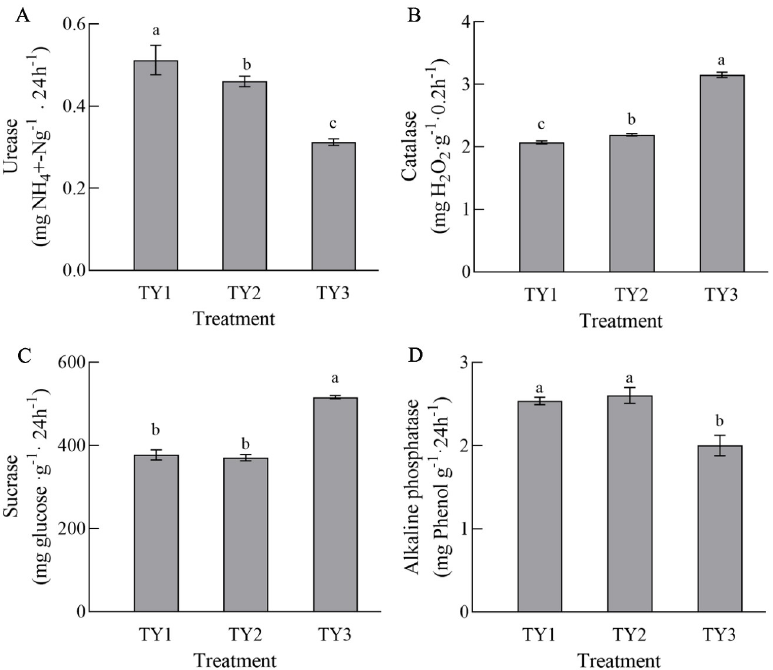
Fig 5. Effects of different planting patterns on the enzyme activities of soil. Different lowercase letters in the same panel indicate significant differences at the 0.05 level. In each panel, bar charts labelled by different letters indicate significant differences according to a one-way analysis of variance (ANOVA) (P < 0.05) and Duncan’s Multiple Range Test (DMRT) (P < 0.05). TY1, Tomato continuous cropping; TY2, Eggplant-tomato rotation; TY3, Arrowhead- tomato rotation.